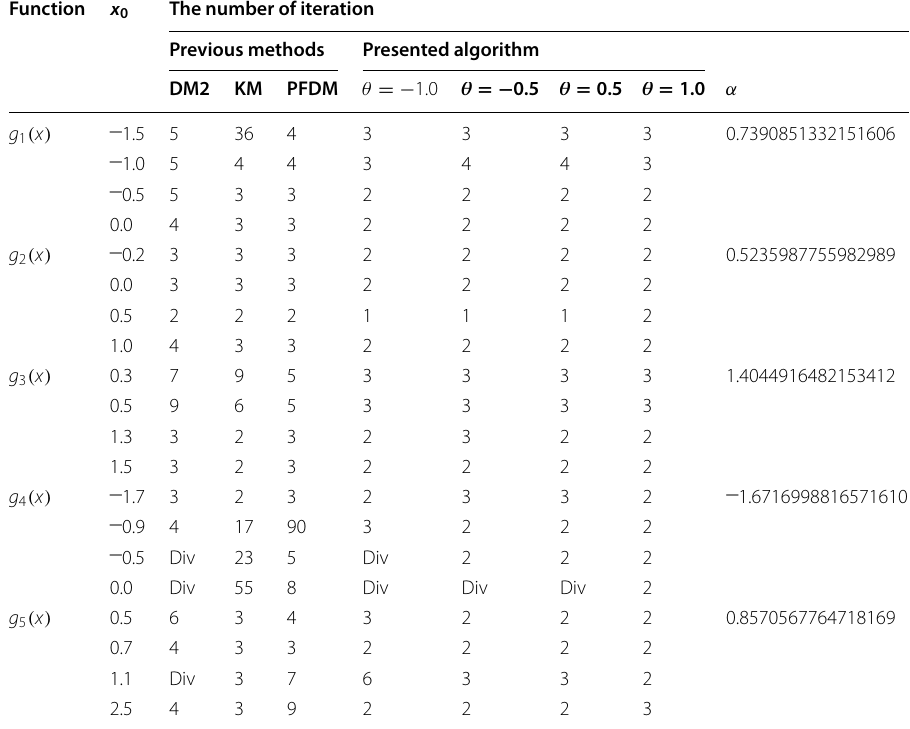
Table 2 Comparison of different methods for solving test functions Function x 0 The number of iteration